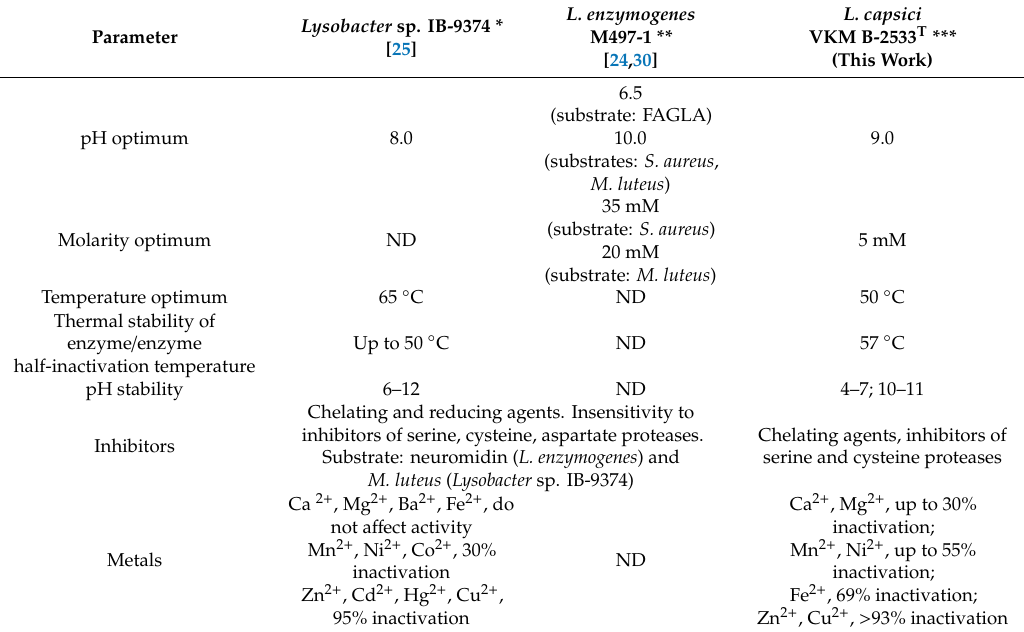
Table 5. Physico-chemical properties of